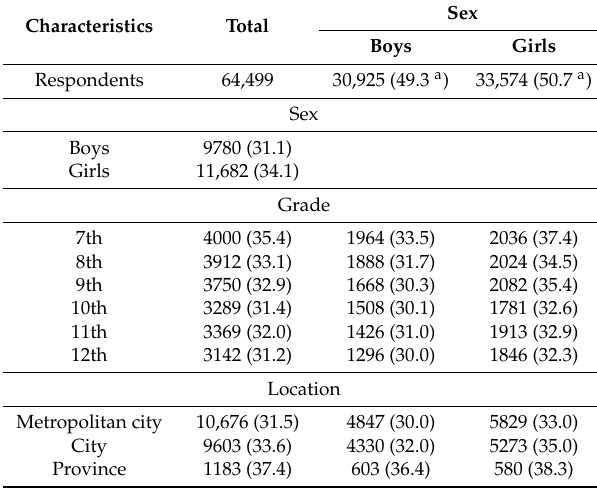
Table 1. Prevalence of exposure to second-hand smoke at